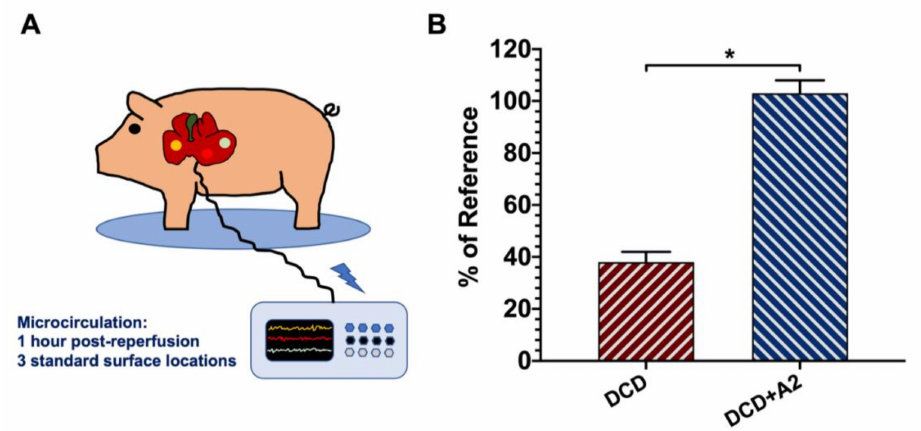
Figure 1. Hepatic microcirculation. ( A ) Graft microcirculation was evaluated one hour after reperfusion at three standard locations on the surface of the liver using a laser Doppler monitor and corresponding surfaceprobe. Themeanvalueofthemeasurementpointswasusedtocharacterizegraftmicrocirculation. ( B ) Due to the large individual variations between animals, the data were expressed as a percentage of the baseline value (mean ± standard error of the mean (s.e.m.), * p < 0.05 donation after circulatory death (DCD) + A2 vs. DCD, Student’s t-test, n = 5 / group).